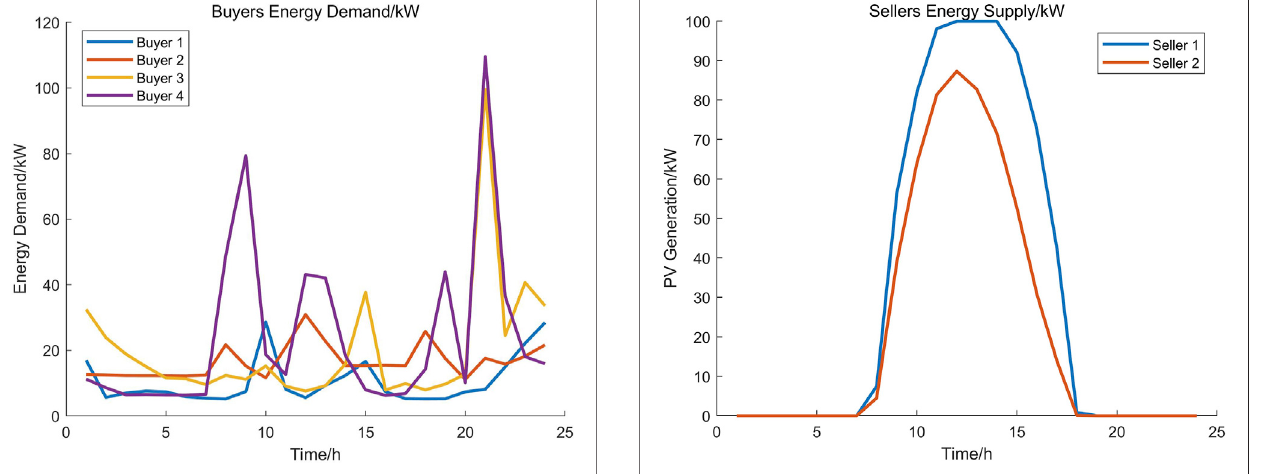
FIGURE 9 | Buyers ’ energy demand in 24 h